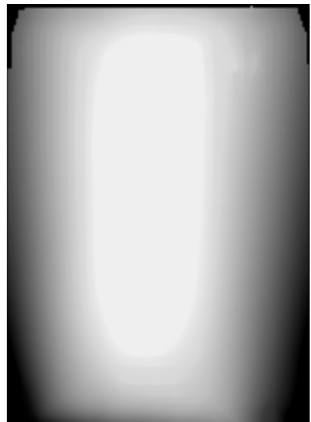
Figure 10. (a) Unwrapped interferogram, (b) 3D image of displacement of the entire